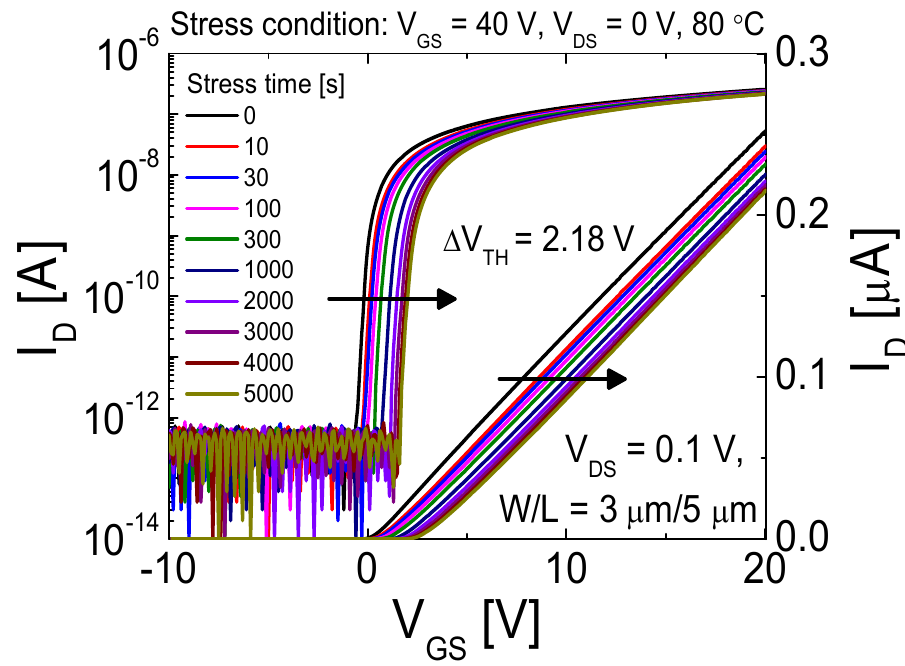
Figure 2. Time evolution of the transfer curves for the fabricated SA ‐ TG coplanar IGZO TFT under a constant V GS of 40 V and V DS of 0 V at 80 °C. Therefore, the effects of PBTS on the subgap DOS in the channel layer must be exam ‐ ined before quantitatively analyzing the PBTS ‐ induced trapped electron distribution within the gate dielectric in IGZO TFTs. Figure 3a,b demonstrate the energy distribution of the subgap DOS extracted using the MPCV technique before and after the application of the PBTS ( V GS = 40 V, V DS = 0 V, 80 °C) for a stress time ( t st ) of 5000 s. The results presented in Figure 3 show that the difference between the energy distribution of the subgap DOS extracted from the TFT before and after PBTS was minimal, indicating that the electron injection from the channel (IGZO) to the gate dielectric (SiO 2 ) in the fabricated SA ‐ TG IGZO TFTs caused the PBTS ‐ induced transfer curve shift observed in Figure 2.